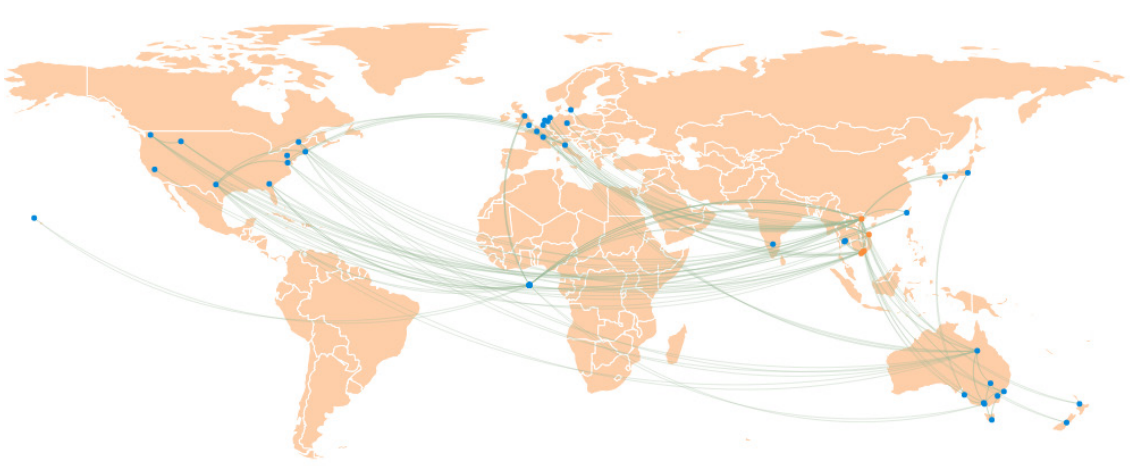
Figure 3. Map of Vietnamese and international